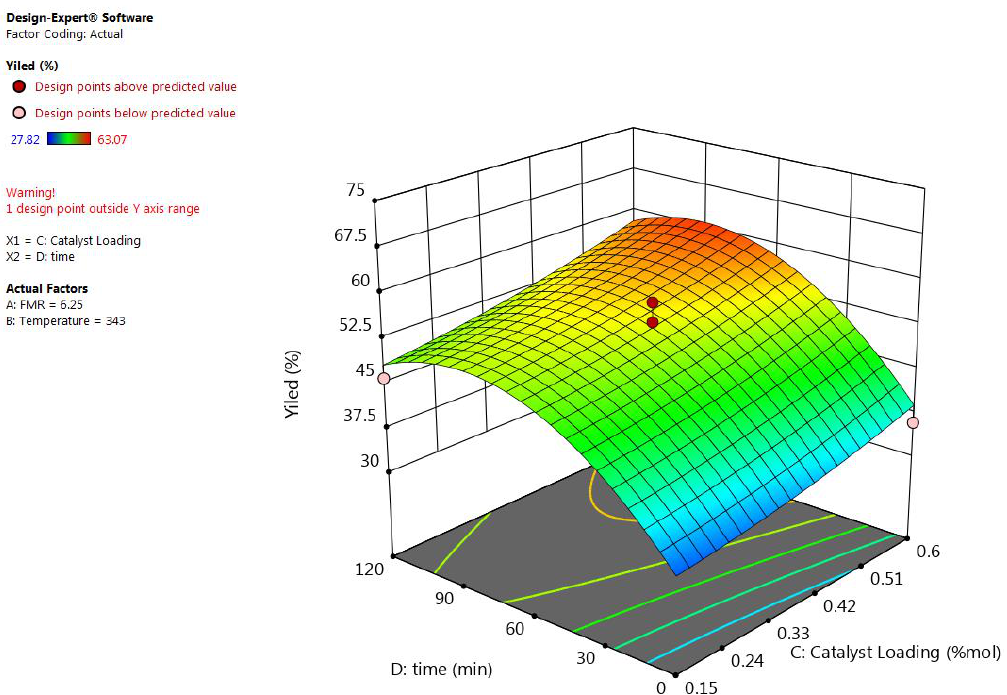
Figure 11. The effect of reaction time on the yield of 1,2-epoxy-5-hexene.